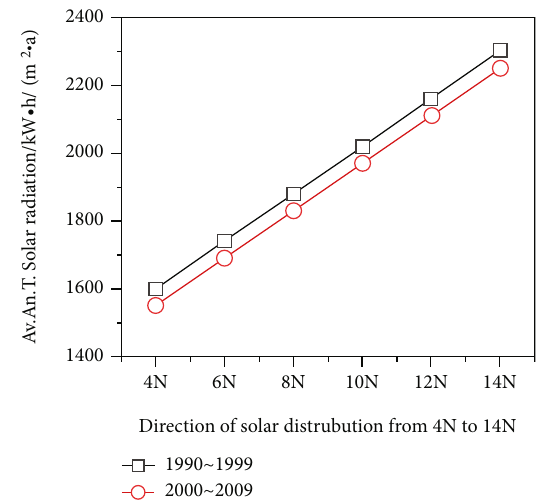
Figure 11: Average annual solar radiation distribution from 4 ° N to 14 °